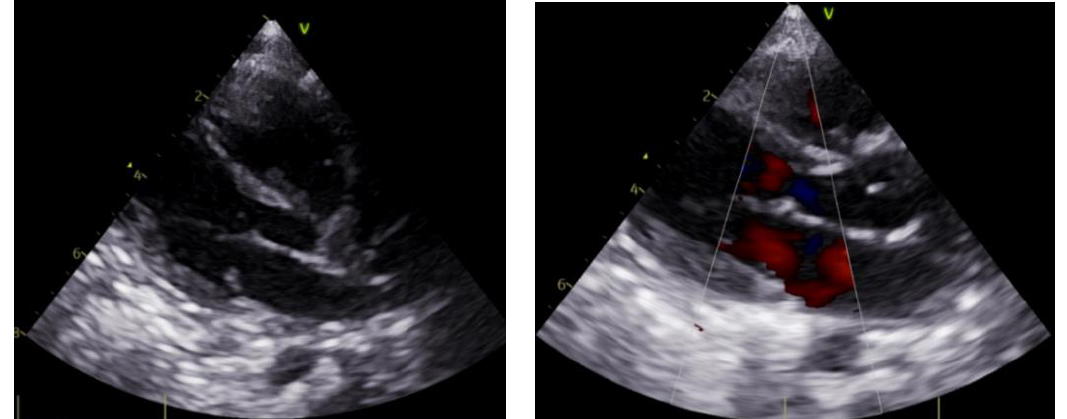
Figure 1. Bedside transthoracic echocardiogram showing normal left ventricular systolic function.